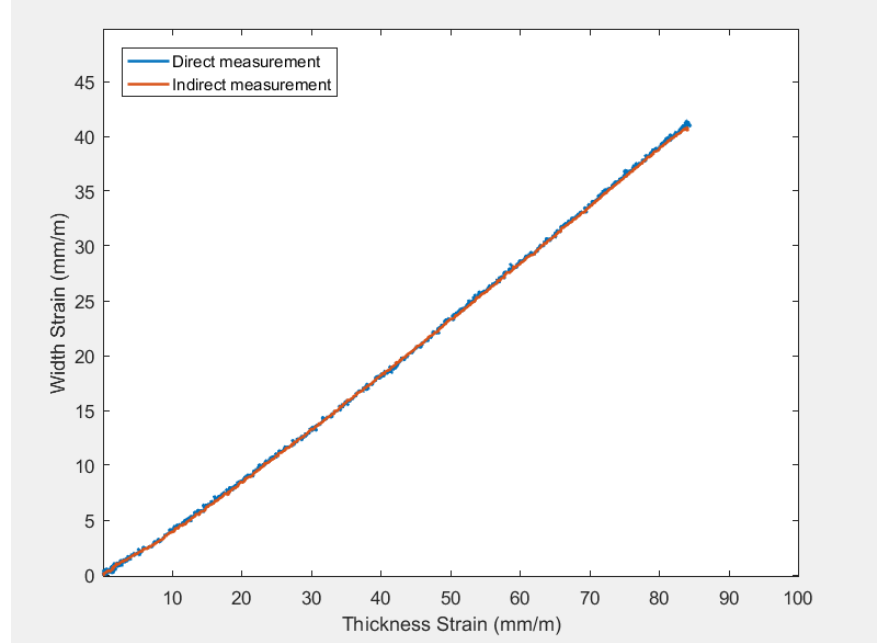
Figure 16. R-value curves of aluminum alloy 6061 in the non-necking area.